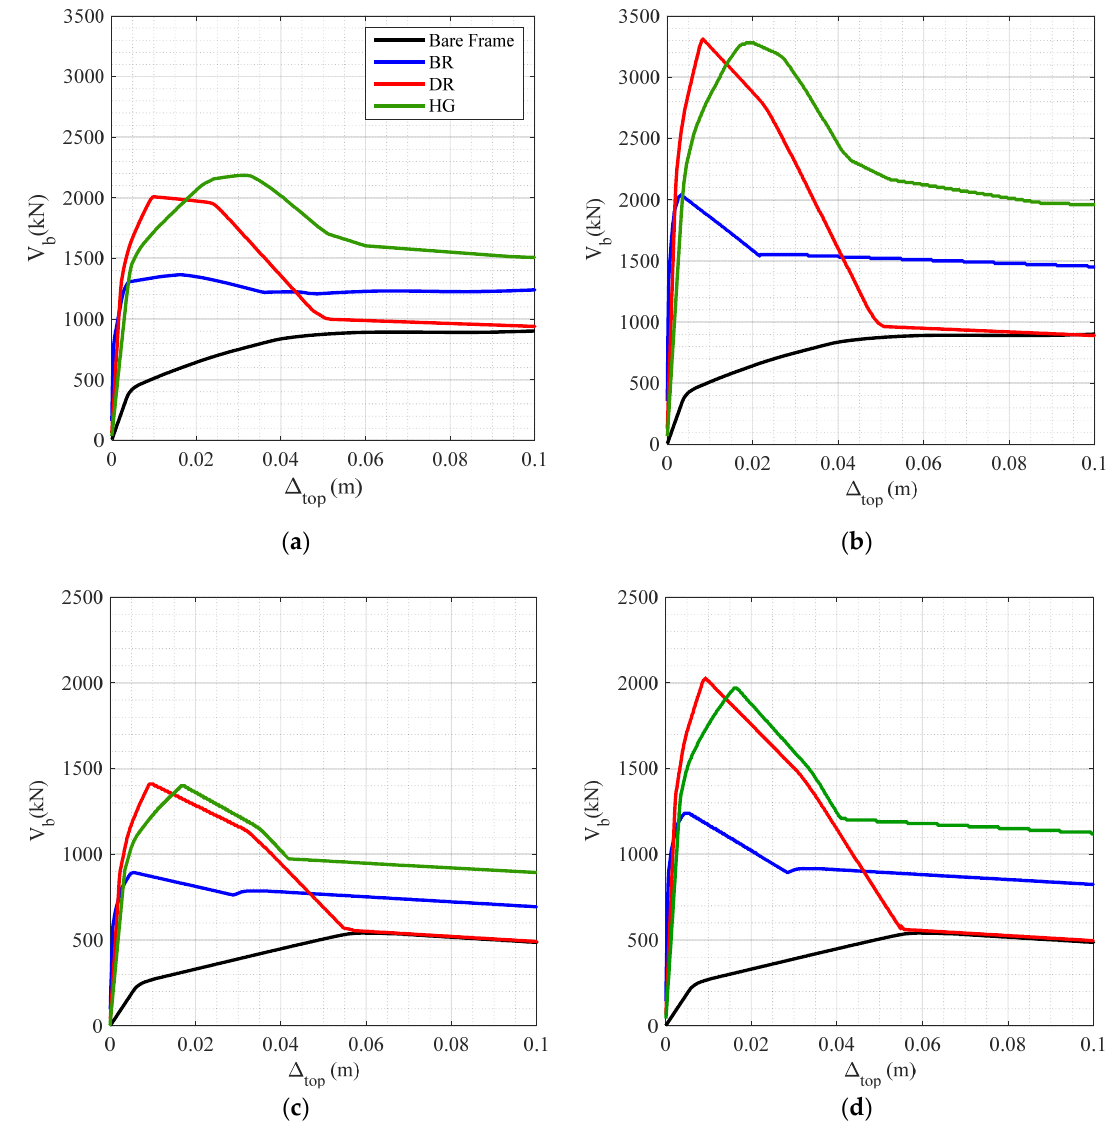
Figure 7. Pushover curves in the longitudinal ( a , b ) and the transverse ( c , d ) direction for ( a , c ) the actual opening configuration and ( b , d ) simulating no openings, obtained adopting DR, HG, and BR constitutive laws.